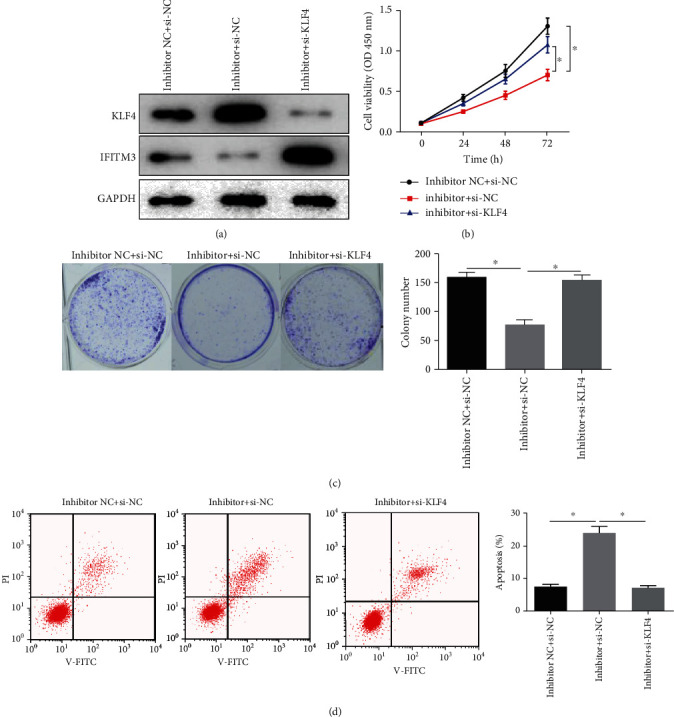
miR-152-3p affects colon cancer cell proliferation and apoptosis via the KLF4/IFITM3 axis. (a) Western blot was carried out to determine the protein expression of KLF4 and IFITM3 in cells transfected with inhibitor NC+si-NC, miR-152-3p inhibitor+si-NC, and miR-152-3p inhibitor+si-KLF4. (b) CCK-8, (c) colony formation assay, and (d) flow cytometry were conducted to assay cell viability, colony-forming ability, and apoptosis in each treatment group (∗ means p < 0.05).